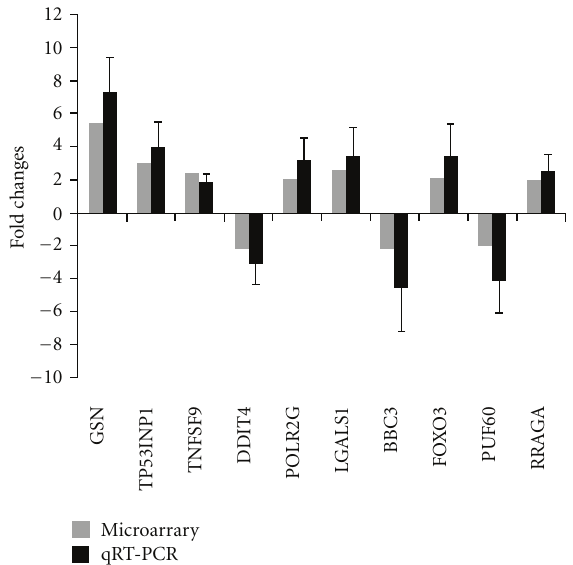
Figure 1: Alterations in the expression levels identified by microar- ray were confirmed using qRT-PCR. Fold changes between K562 cell line treated with and without valproate detected by microarray were compared with those measured by qRT-PCR. In qRT-PCR assay, RNA was isolated from K562 cell line treated with or without valproate exclusively for validation of di ff erentially expressed genes. mRNA levels were normalized with GADPH and fold changes were calculated by dividing mRNA level of each K563 cell line treated with valproate by mean mRNA level from control samples in triplicate. Data are mean values ± standard deviations of the means from three independent experiments performed in